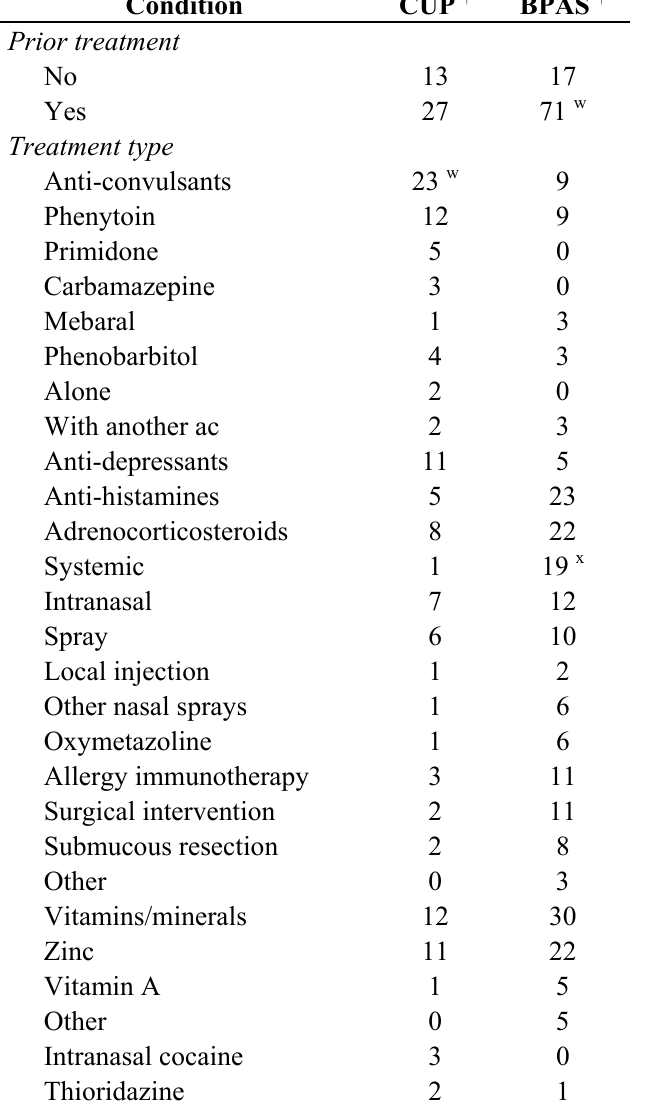
Table 10. Treatment prior to evaluation at The Taste and Smell Clinic in patients with